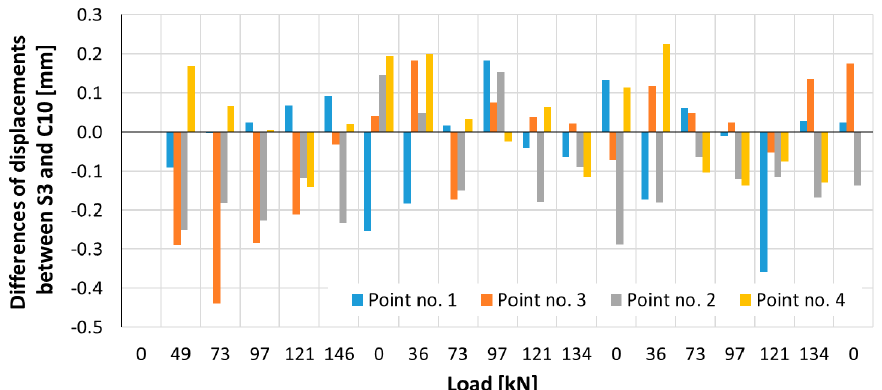
Figure 13. The differences of vertical displacement values between the results obtained from the total station S3 and the laser scanner C10.